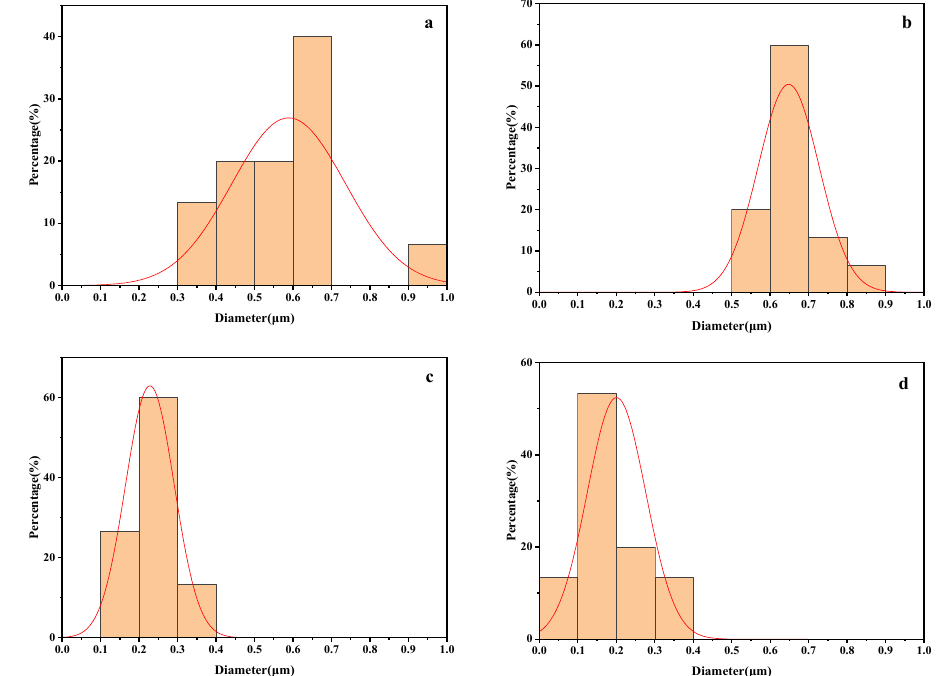
Figure 6. Diameter distribution of TiO 2 filler: ( a ) 1% TiO 2 /PLA; ( b ) 3% TiO 2 /PLA; ( c ) 5% TiO 2 (KH-570)/PLA; ( d ) 10% TiO 2 (KH-570)/PLA.